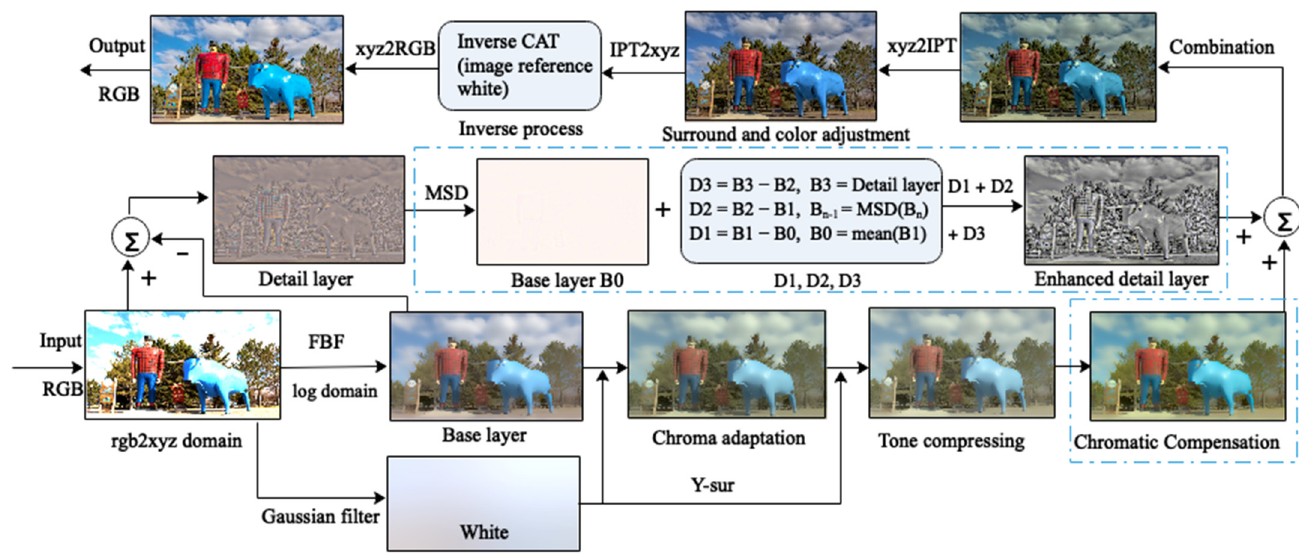
Figure 1. Flowchart of the modified algorithm for HDR images tone-mapping. The FBF was per- formed in the log domain, and then the images were converted to the XYZ space. All the images displayed are in the RGB space. The “White” was the adapted image, which is an extremely blurred image. The “Y-sur” is the luminance channel of “White” denoting the surrounding luminance. In MSD, B0 with no gradient was discarded, and the enhanced detail layer was the sum of three details: D1, D2, and D3. The calculation can refer to the following.